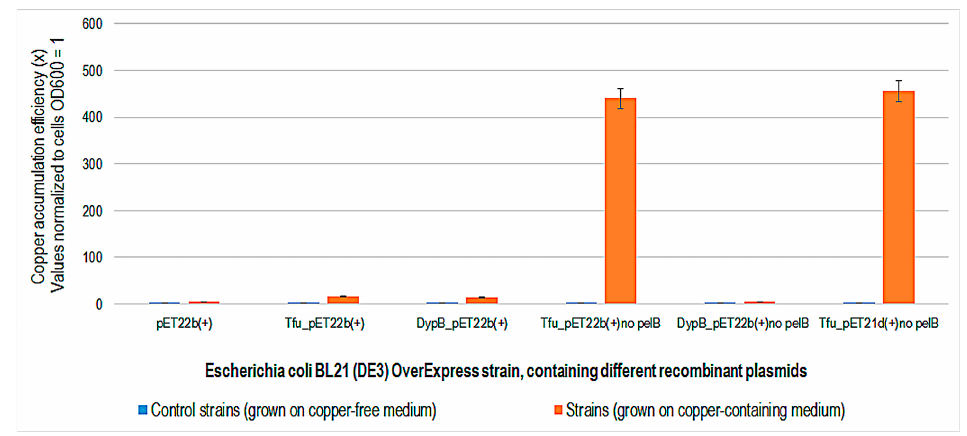
Figure 6. Copper accumulation efficiency (x) in Escherichia coli BL21 (DE3) OverExpress containing different recombinant plasmids expressing peroxidase after 48 h of expression in copper-containing Luria-Bertani-isopropyl β -D-1-thiogalactopyranoside -ampicillin medium at 35 °C. Control strains were grown in copper-free medium.